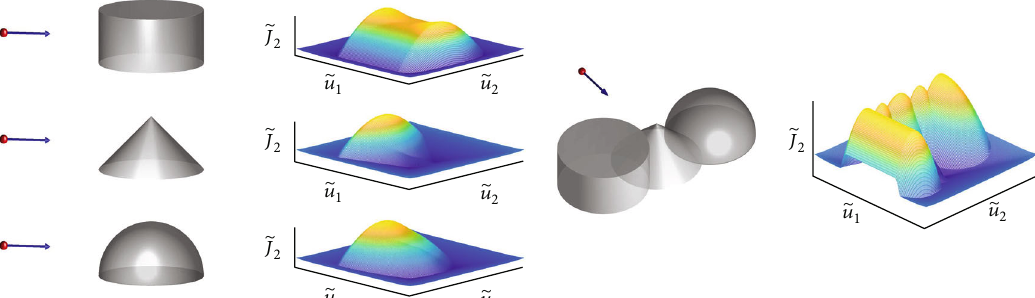
Figure 6: Function images of ~ J